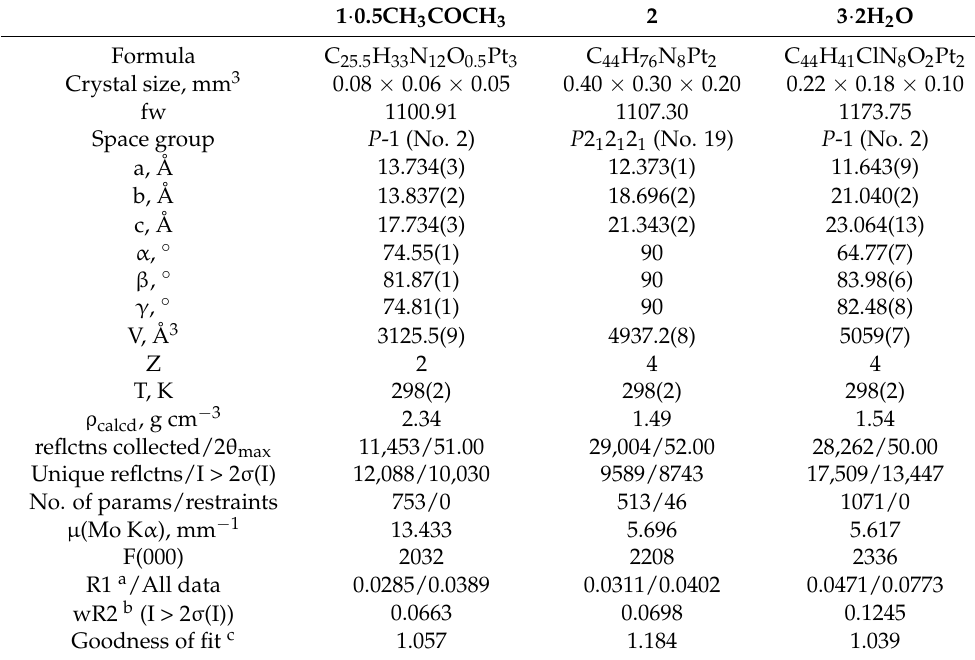
Table 3. Crystallographic data for 1 , 2 , and 3